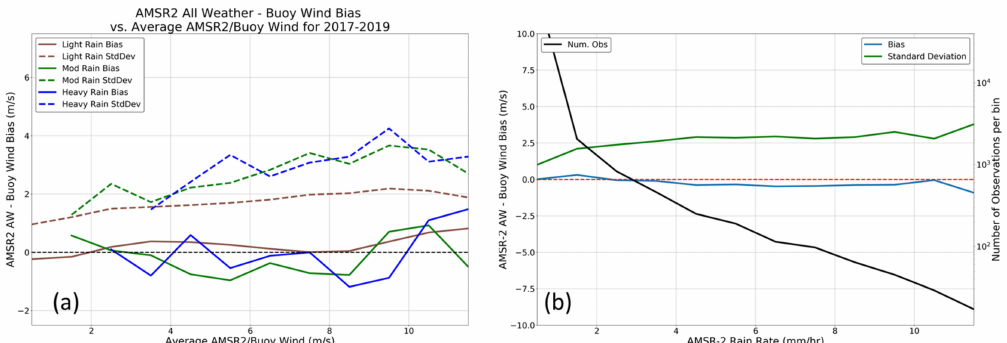
Figure 15. Comparison between global AMSR2 all-weather and buoy wind speeds. ( a ) Bias (full lines) and standard deviation (dashed lines) of the AMSR2–buoy wind speed difference as function of the average between AMSR2 and buoy wind speed. The 3 colors indicate 3 different rain regimes: Brown = light rain (AMSR2 rain rate above 0 and below 4 mm/h). Green = moderate rain (AMSR2 rain rate between 4 and 8 mm/h). Blue = heavy rain (AMSR2 rain rate above 8 mm/h). ( b ) Bias (blue) and standard deviation (green) of AMSR2–buoy wind speed as function of AMSR2 rain rate using 1 mm/h bins. Observations in which the buoy wind speed exceeds 15 m/s have been excluded. The black line indicates the number of observations in each rain rate bin.